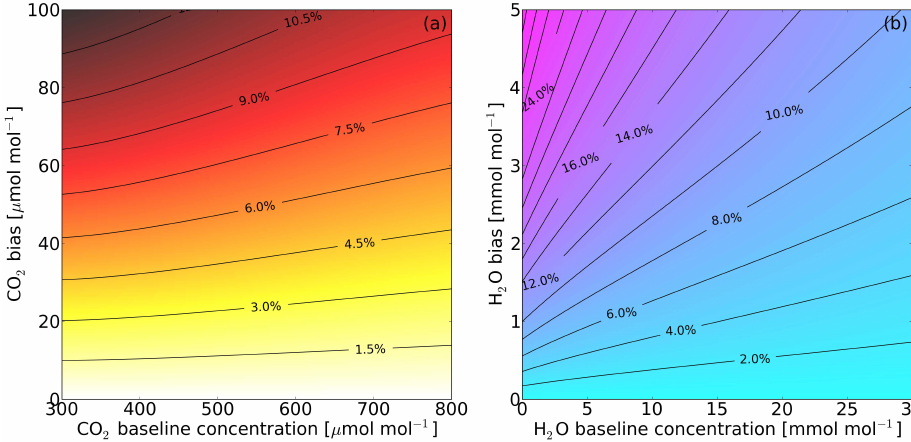
Fig. 3. Relative error (cid:15) f in the estimation of a 0.1µmolmol − 1 CO 2 concentration fluctuation (a) and of a 0.1mmolmol − 1 H 2 O concentration fluctuation (b) as a function of the baseline concentration ( x axis) and of the concentration bias ( y